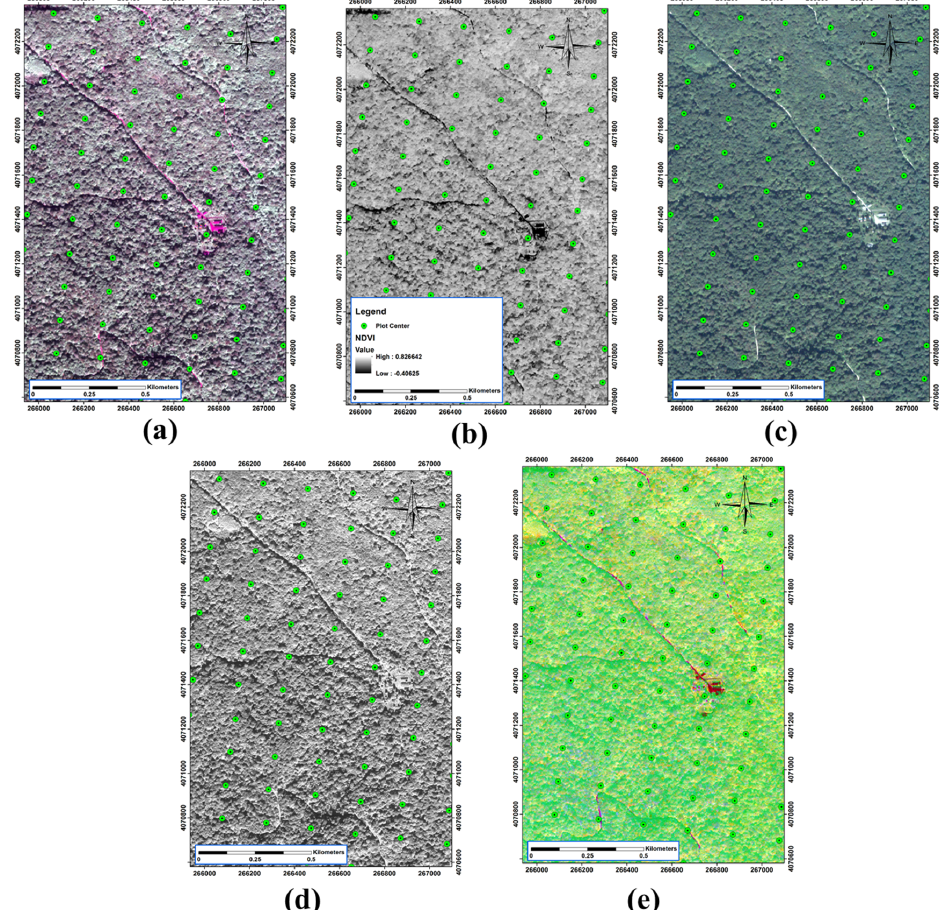
Figure 3. Illustration of some of the satellite outputs. ( a ) tasseled cap; ( b ) normalized difference vegetation index ( NDVI); ( c ) multispectral image; ( d ) panchromatic image; ( e ) principal component analysis (PCA) band 1.